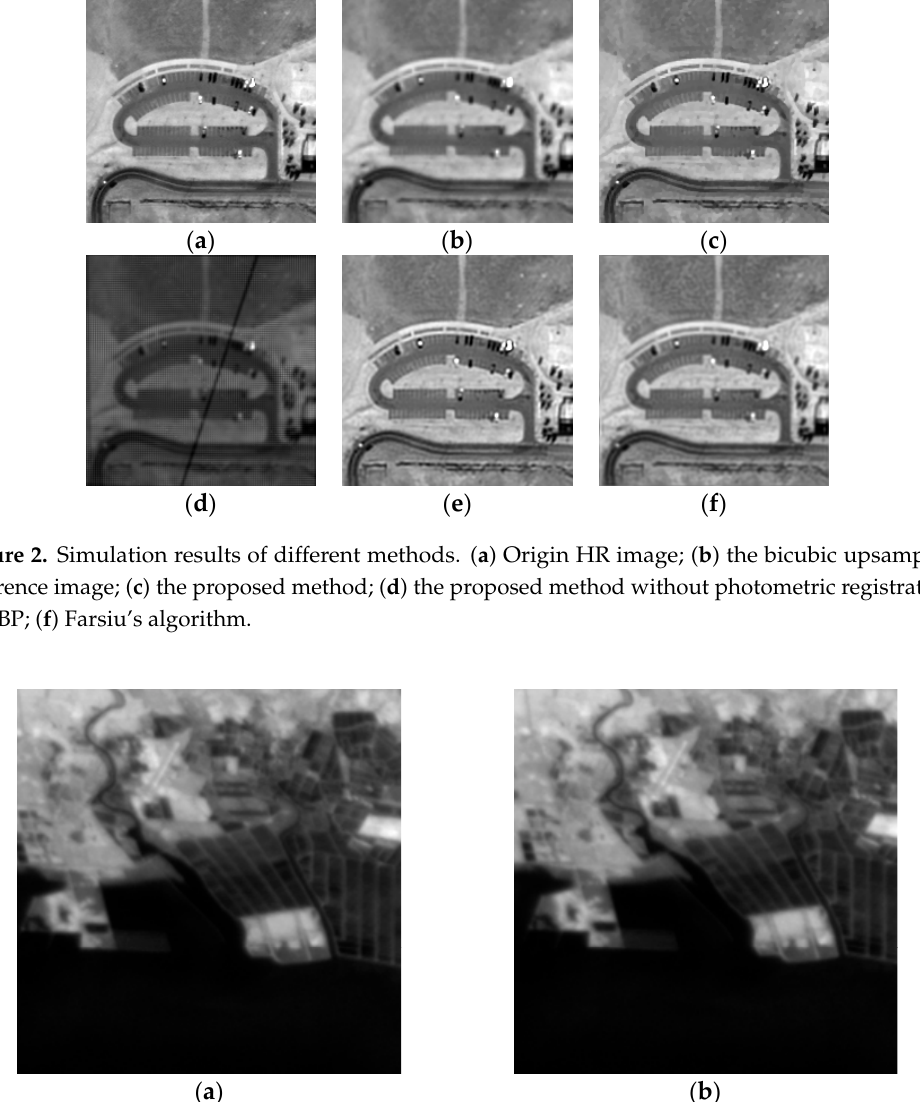
Figure 3. Two LR images: ( a ) captured at 11:10:20; and ( b ) captured at 11:20:21.